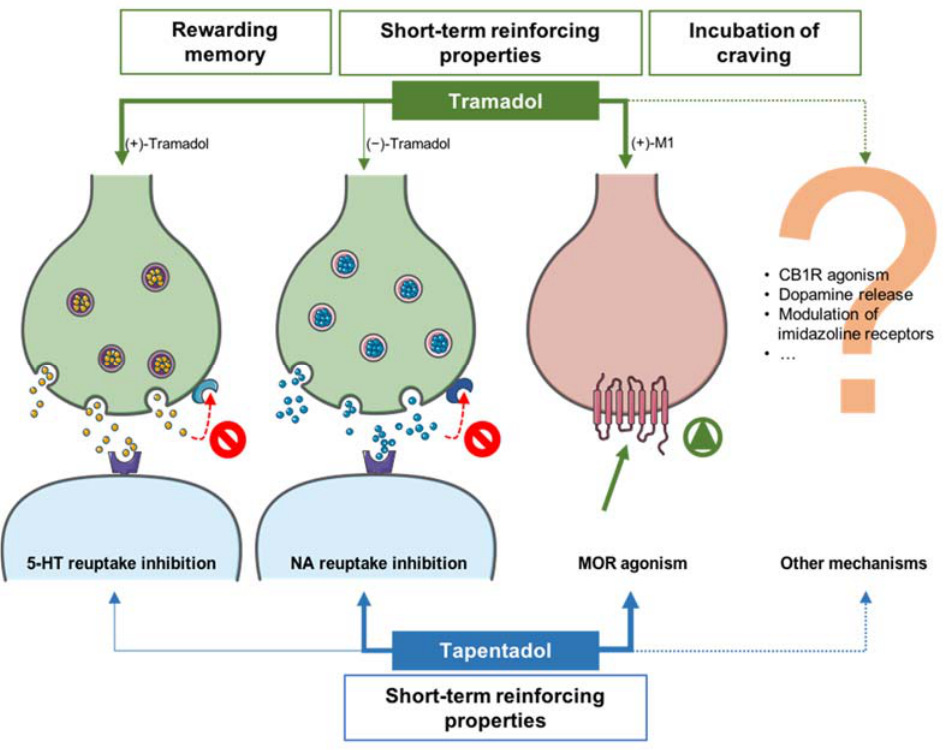
Figure 4. Summary of tramadol and tapentadol mechanisms of action and CPP behavioral effects. Arrow thickness depicts the approximate relative intensity of each effect. Regarding tramadol, the parent drug or metabolite enantiomer predominantly responsible for each effect is specified. 5 ‐ HT: 5 ‐ hydroxytryptamine/serotonin; CB1R: cannabinoid receptor 1; M1: O ‐ desmethyltramadol; MOR: μ‐ opioid receptors; NA: noradrenaline. Red circumferences with diagonal lines: 5 ‐ HT/NA reuptake inhibition; green circumference with triangle: MOR activation.